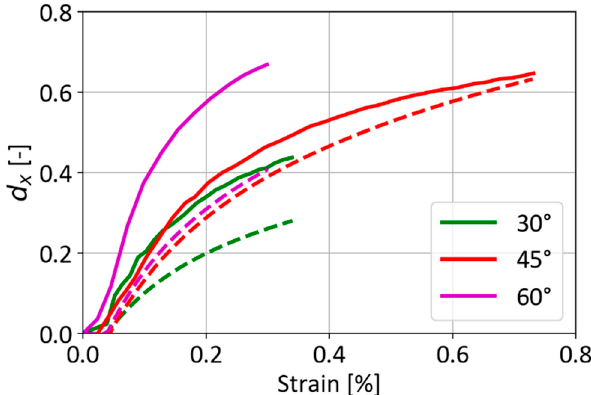
Figure 6. Comparison between damage curves obtained from experiments (solid line) and simulation (broken line) for C/C–SiC.